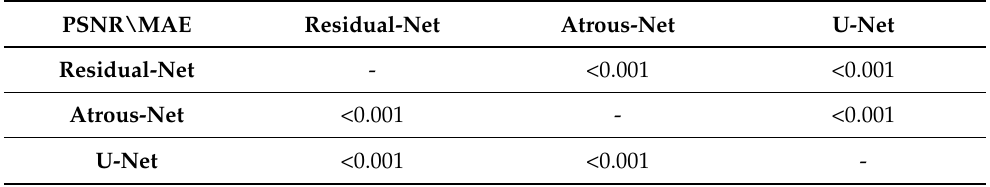
Table 13. MAE and PSNR p -values for 2D Head. p -values of paired Student’s t -test for MAE and PSNR results with 2D architectures with the head dataset.